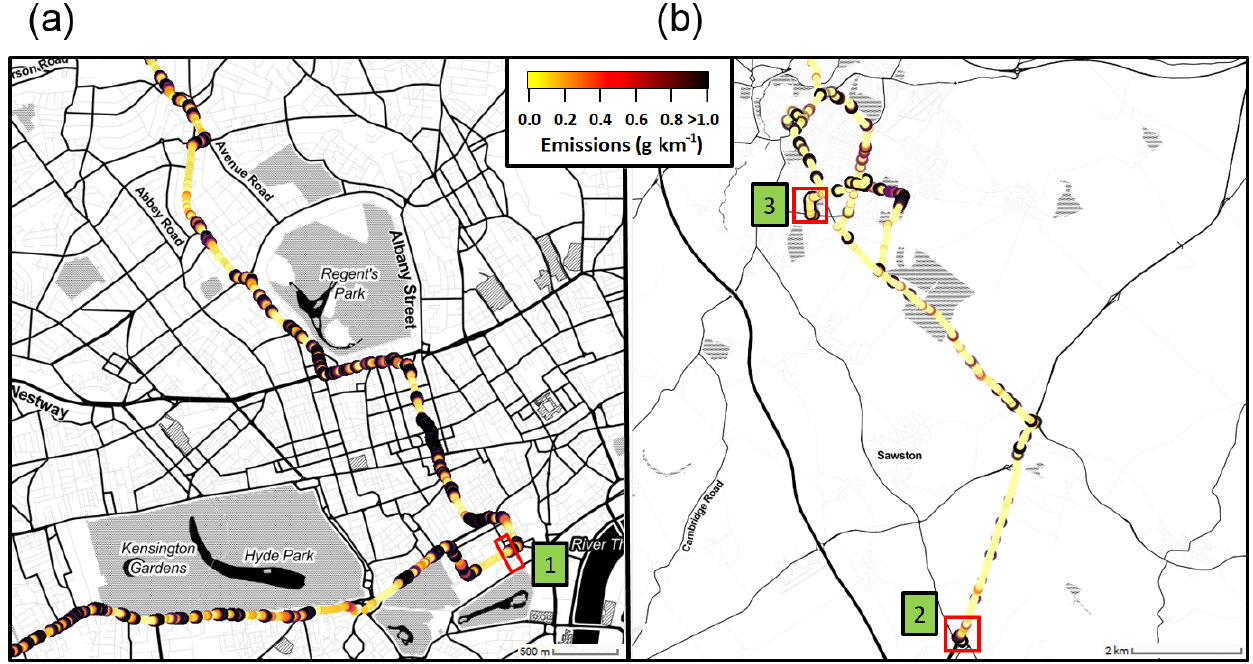
Figure 2. Overview maps showing NO x emissions from the diesel and gasoline vehicles driven around London (a) and Cambridge (b) . Tailpipe emissions higher than 1gkm − 1 per GPS point are circles coloured in black. Points of interest are numbered: (1) traffic